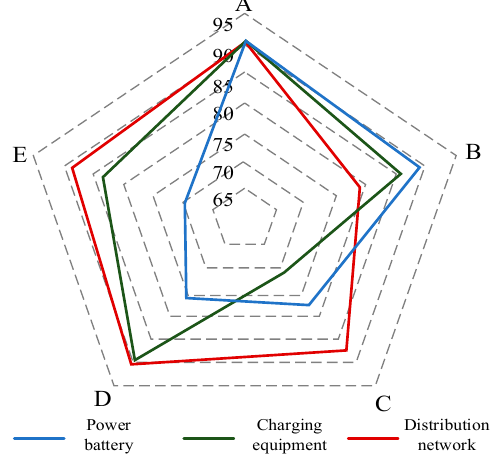
Figure 10. Evaluation results of five charging data in a region of Nanjing in 2020.